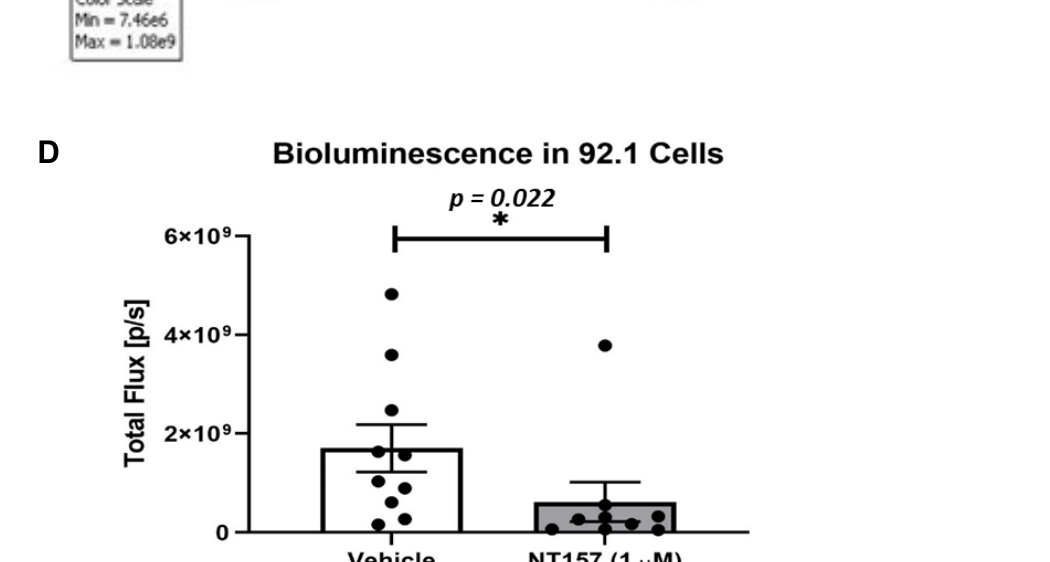
Figure 4. NT157 treatment reduces UM tumor growth in the chicken CAM model. ( A ) H&E (left) and pan melanoma cocktail (anti- HMB1, Tyrosinase, and S100 antibodies; right) staining of UM tumor tissues from 92.1 cells grown in chicken CAM model show the presence of melanoma cells. Representative (20 × ) and high magnification (inlay 2 × ) images shown as described. ( B ) Brightfield images of vehicle-treated (upper panel) and NT157-treated (1 µ M; lower panel) representative tumors (two representative images per treatment) show a reduction of tumor size with NT157 treatment for four days. ( C ) Representative bioluminescence images of chicken eggs bearing luciferase-tagged UM cells (92.1) treated with vehicle controls (left panel) or NT157 (1 µ M for four days) (right panel). ( D ) Tumor size of the implants was calculated as the total flux (photons per second) from the images in ( C ), which shows a reduction in tumor size with NT157 treatment; mean ± SD of three independent experiments was plotted as a graph; * p = 0.022. A student t -test was used for statistical